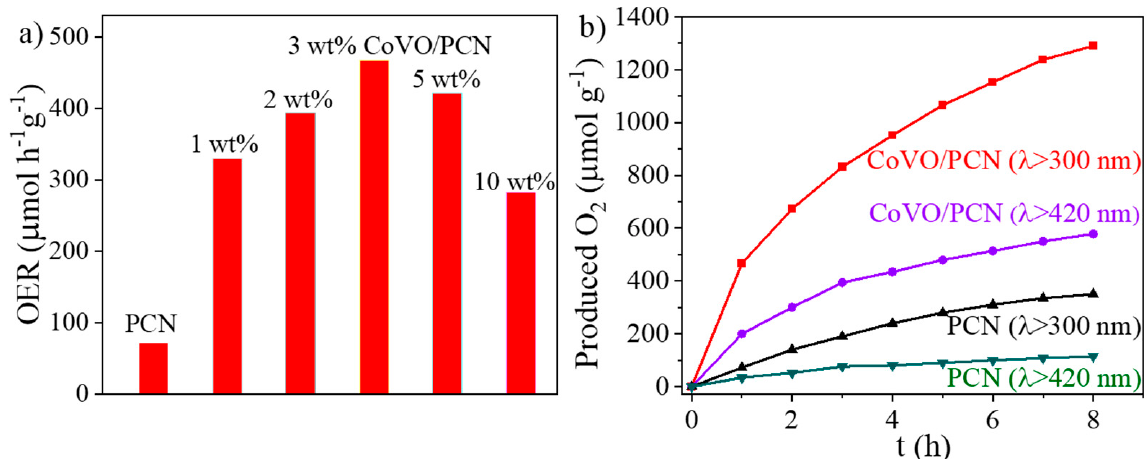
Figure 4 . Photocatalytic O 2 evolution curves of ( a ) x wt % CoVO/PCN samples under UV irradiation ( λ > 300 nm); ( b ) eight − hour continuous test of 3 wt % CoVO/PCN sample under UV ( λ > 300 nm) and visible light irradiation ( λ > 420 nm).